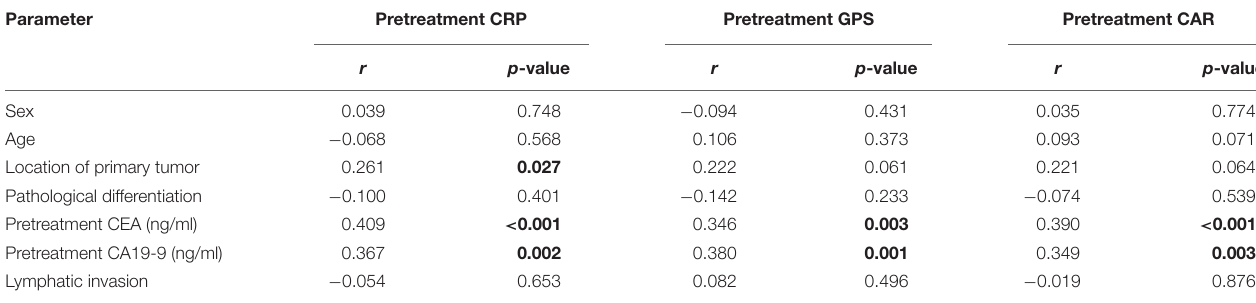
TABLE 3 | Significant correlations of pretreatment CRP, GPS, and CAR with the clinicopathological features of CRLM patients.